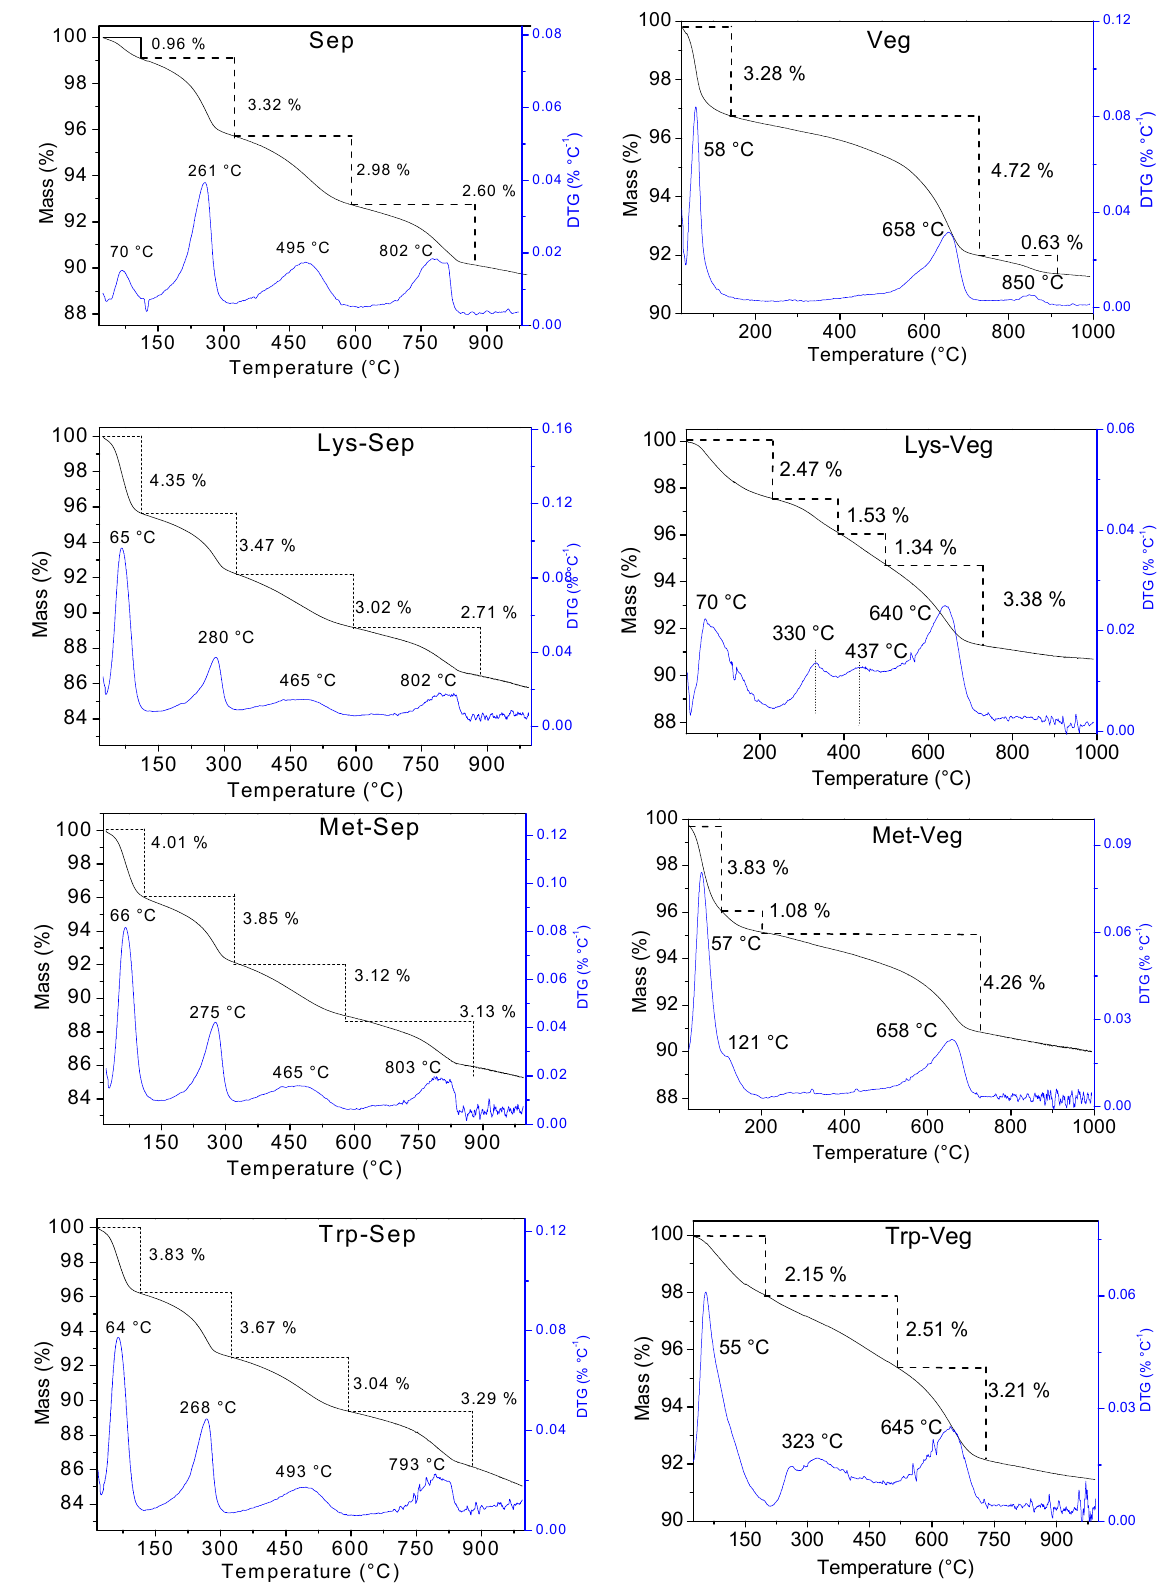
Figure 4. TG/DTG curves of clay minerals before and after amino acids incorporations. The Sep TG curve and derivative (DTG) presented four mass loss events with maximum temperatures (Tmax) at 70, 261, 495, and 802 °C and percentages of mass loss equal to 0.96; 3.32; 2.98 and 2.60%, respectively. The first event was associated with the elimination of water molecules superficially adsorbed on the clay mineral structure. The second was attributed to the loss of interchannel zeolitic water molecules and hydrogen bonds in the fibrous structure. Finally, the last two events were attributed to clay mineral dehydroxylation [29,40]. The three mass loss events observed in the TG/DTG curve of the Veg lamellar clay mineral present Tmax at 58, 658, and 850 °C. The first event was attributed to the elimi- nation of surface water and a loss percentage of 3.28%. The last events were associated with eliminating coordinated water firmly bound with the octahedral sheet and dehy- droxylation from the silanol groups (4.72 and 0.62%, respectively). The total mass loss was 5.34% [24,41,42]. After the incorporation of amino acids into Sep, the degradation events were main- tained. However, organic molecules on the surface or inside the clay mineral channels altered the intermolecular interactions with the physisorbed water molecules and inter- channel. This promoted small changes in temperatures and percentages of mass loss and changes indicative of adsorbed amino acids on the surface or within the fibrous clay mineral channels. In the case of amino acid incorporation in Veg, new thermal degrada- tion events occurred in the range between 120–550 °C, which was attributed to the mass losses of the respective incorporated organic matter. Table 3 serves to identify the differences observed in each degradation event, com- paring the temperatures and respective percentages of loss, where an important obser- vation concerns the increase in the percentage of loss of masses, especially in events from 200–550 °C, for all profiles compared to Sep. This can be attributed to the contributions of